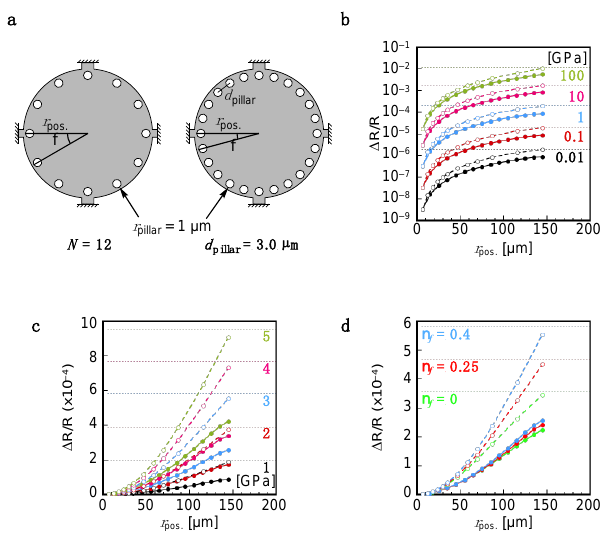
Figure 3. Dependence of the relative resistance change ( ∆ R / R | total ) on the position of the interfacial attachments ( r pos. ) calculated by FEA. ( a ) Configuration of pillars as a model of interfacial attachment. The radius of pillars ( r pillar ) is fixed at 1 µm. ( Left ) Number-fixed model. The number of the pillars ( N ) is fixed at 12. ( Right ) Distance-fixed model. Center-to-center distance between pillars is fixed at ca. 3 µm, indicating that the shortest distance between pillars is 1 µm. Detailed distances are listed in Tables 1 and 2. ( b – c ) Dependence of the total resistance change ∆ R / R | total on Young’s modulus as a function of the position of pillars ( r pos. ). The Young’s moduli ( E f ) are varied from 0.01 GPa to 100 GPa ( b ) and from 1 GPa to 5 GPa ( c ). Poisson’s ratio of a coating film ( ν f ) is fixed at 0.4. ( d ) Dependence of the total resistance change ∆ R / R | total on Poisson’s ratio as a function of the position of pillars ( r pos. ). The Young’s modulus of coating film is fixed at 3.0 GPa, which is similar to that of PMMA. Dotted lines in ( b ), ( c ) and ( d ) are ∆ R / R | total of the full attachment model. Table 1. Detailed parameters of the number-fixed model.